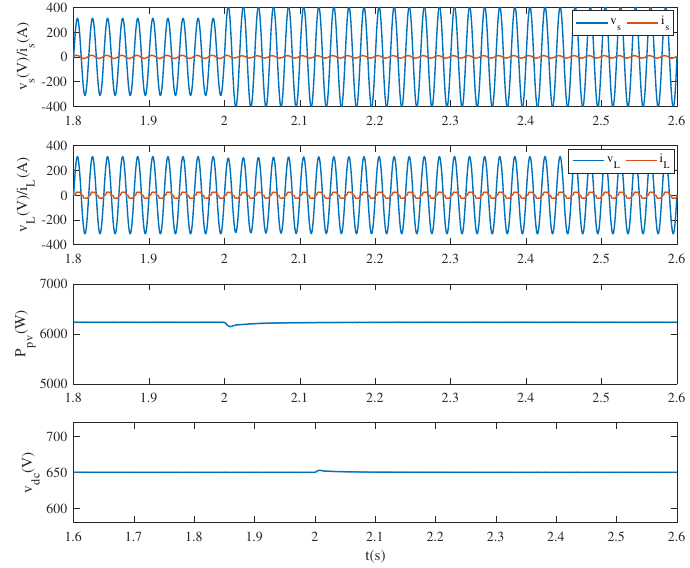
Figure 10. Simulation results under voltage swell with P L > P pv